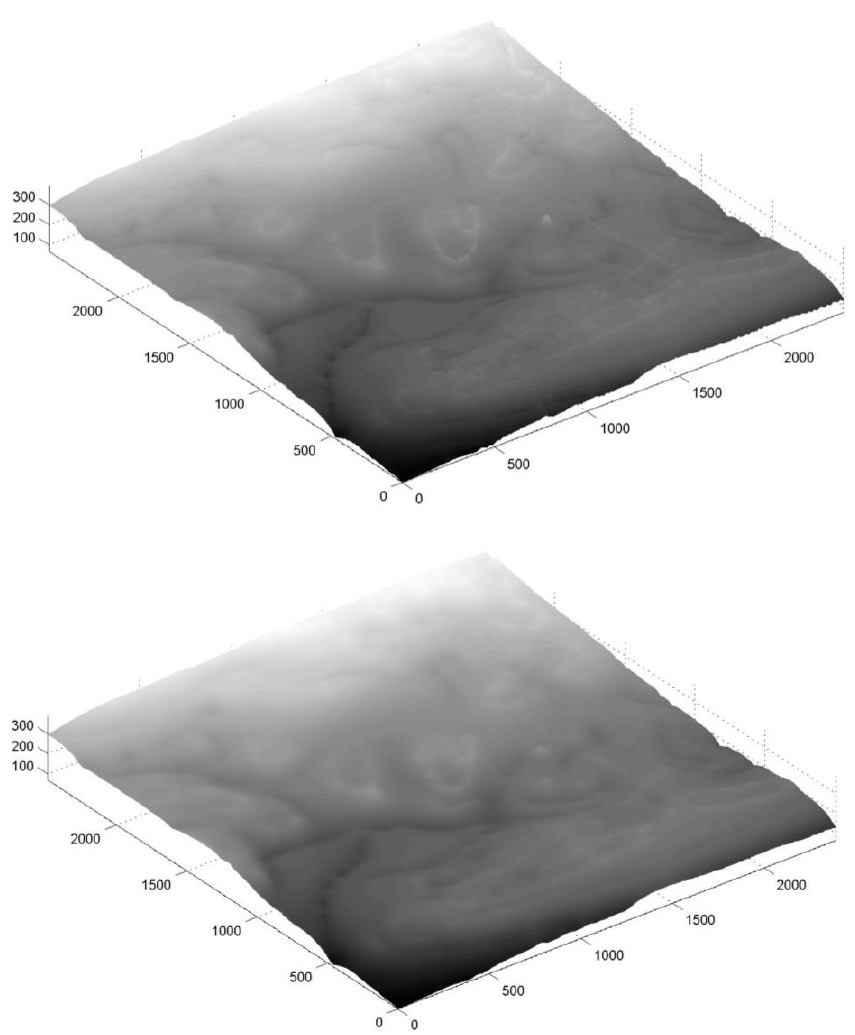
Figure 8. 3D visualization of the 10 m resolution DTM for the entire area: pre-Kalman filter ( top ), and post-Kalman filter ( bottom ) (all values in meters).